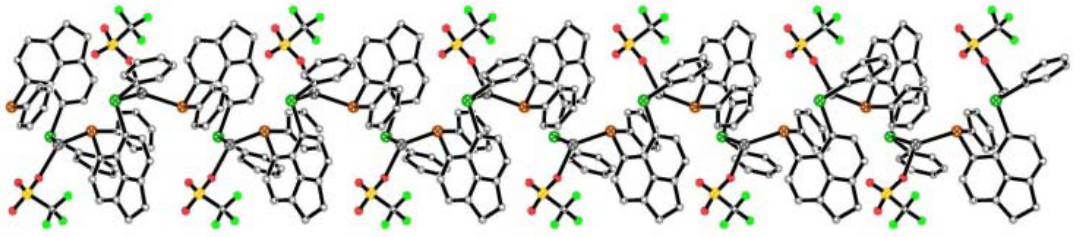
Figure 9. View of the 1D extended helical chain polymer 6 along the x-axis (H atoms and solvent molecules omitted for